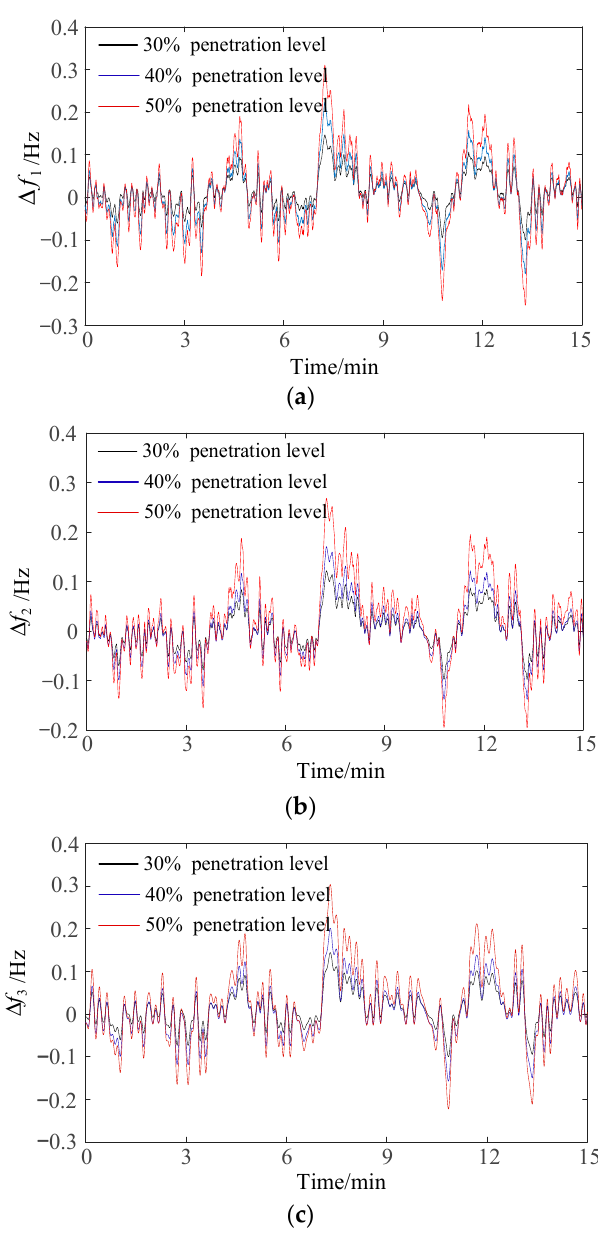
Figure 10. Frequency deviation of three-area system under different wind power penetration: ( a ) Area 1; ( b ) Area 2; ( c ) Area 3.